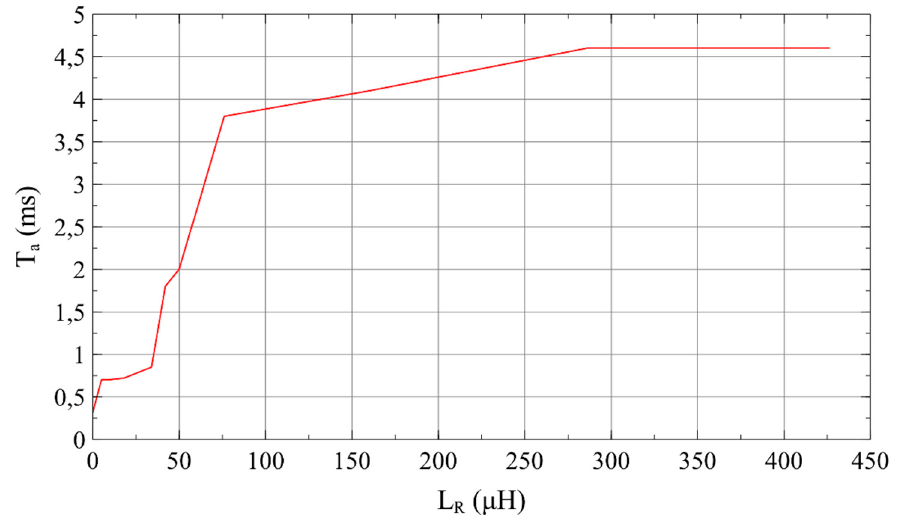
Figure 8. The dependence of series inductance in the L R arc branch from the arc time T a .